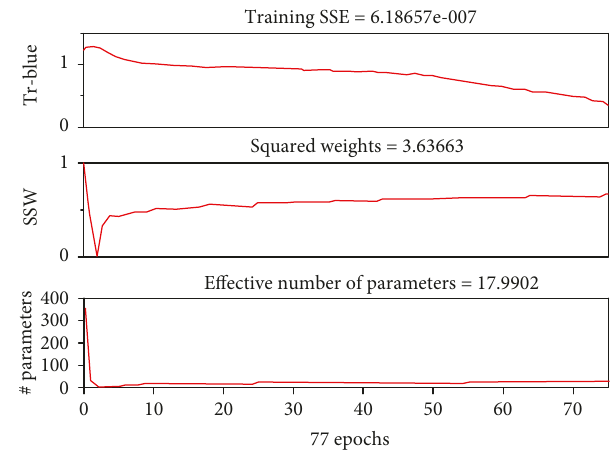
Figure 9: Bayesian training